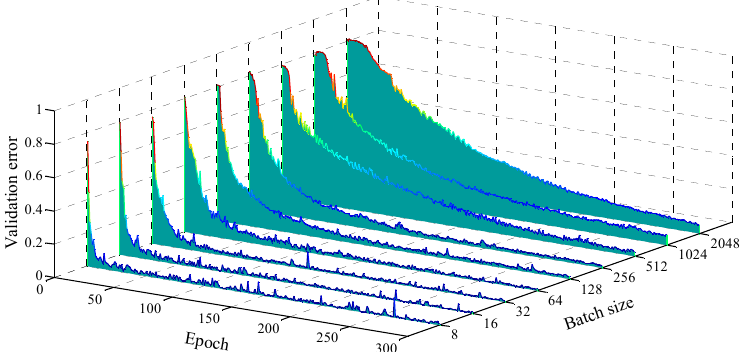
Figure 13. The e ff ect of the batch size on the convergence process of the validation Figure 13. The effect of the batch size on the convergence process of the validation error.